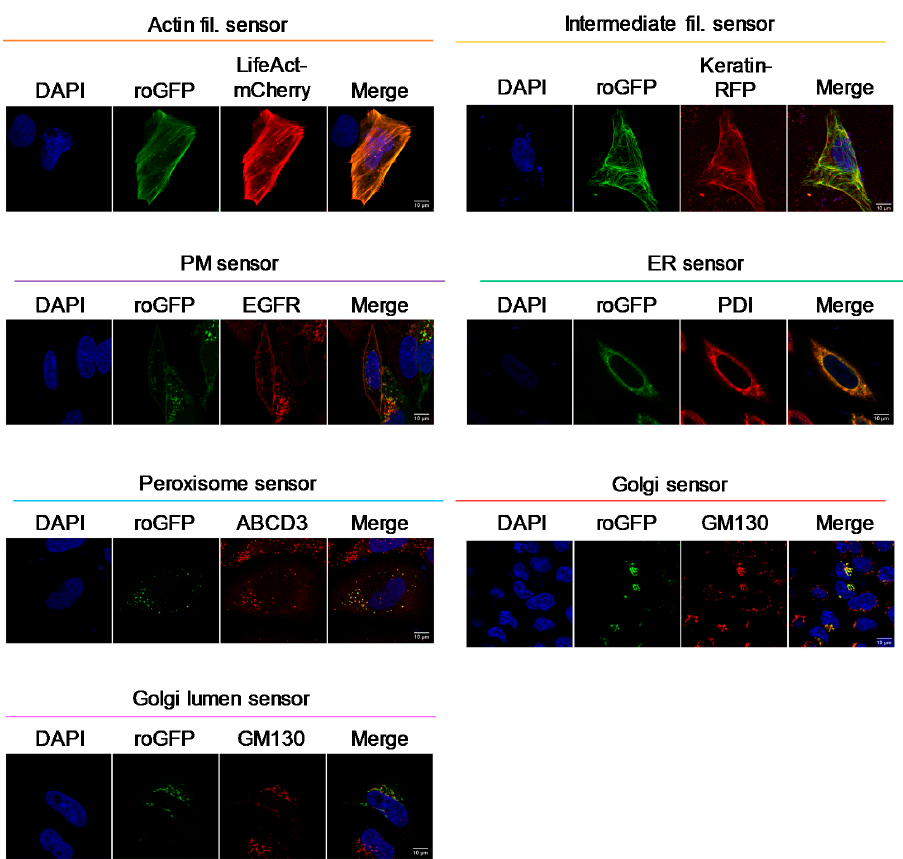
Figure 3. Successful targeting of Grx1-roGFP2 to the cytoplasmic sides of various organelle membranes. DNA constructs were transfected into HeLa cells and protein localization was analyzed byimmunostainingfororganelle markers; GM130 at the Golgi membrane, epidermal growth factor receptor (EGFR) at the plasma membrane, ABCD3 at peroxisome, and protein disulfide isomerase (PDI) at endoplasmic reticulum. LifeAct-mCherry and Keratin-mCherry were used as markers of actin and intermediate filaments. Scale bars, 10 µ